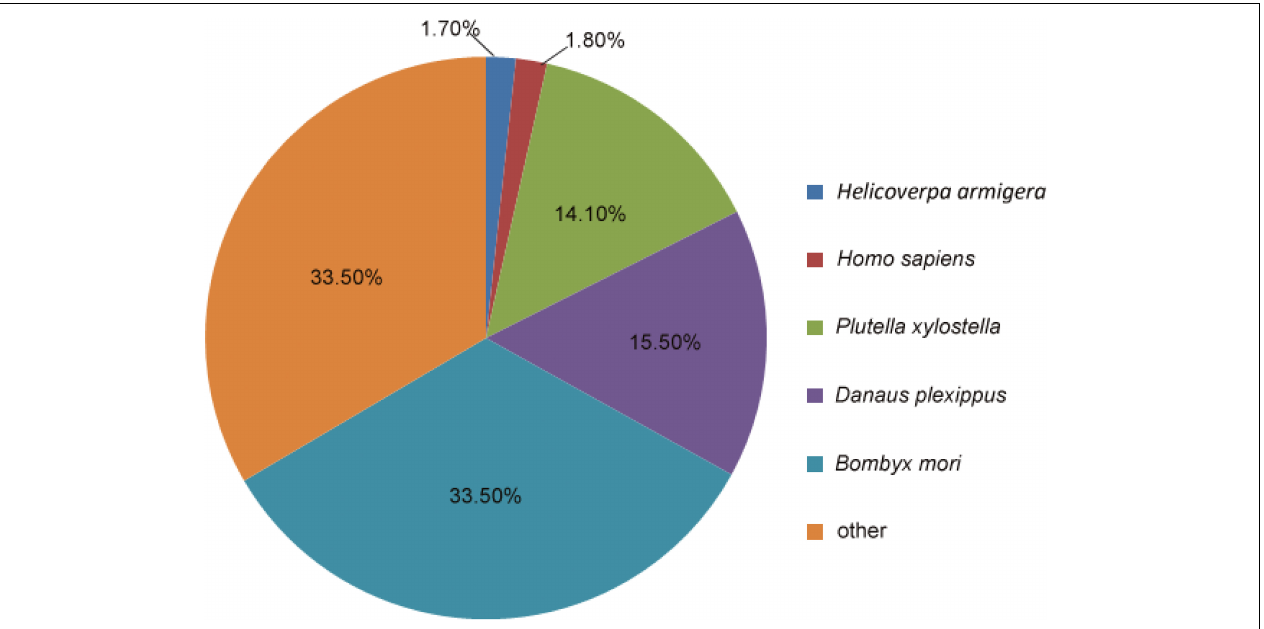
FIGURE 1 | Proportional homology distribution among other insect species based on the best BLAST hits against the NR database for the assembled unigenes from the Mythimna separata brain transcriptomes.